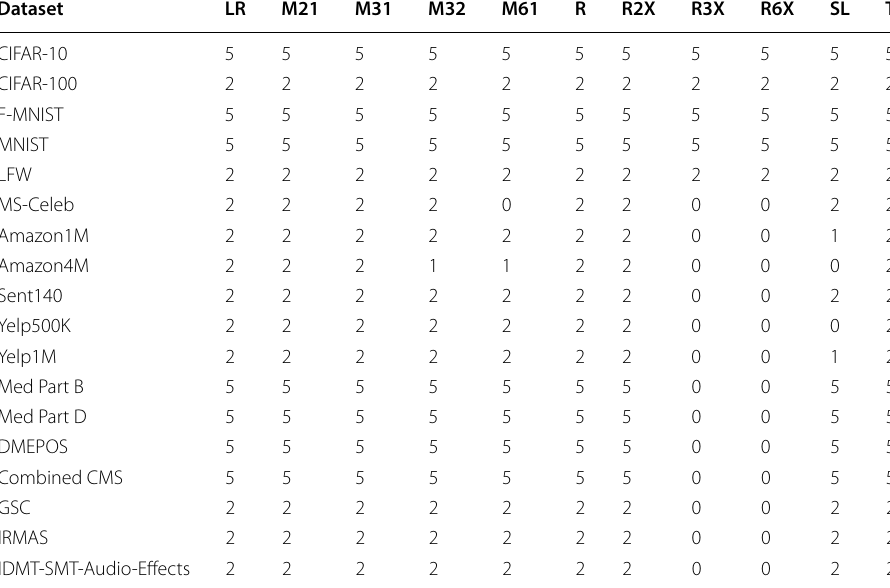
Table 4 Number of experiments per activation and dataset